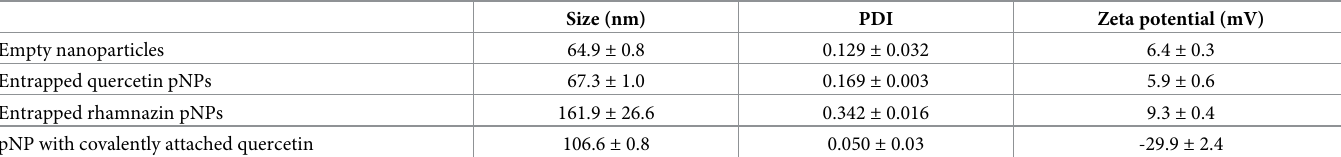
Table 1. Physical Characteristics of the nanodelivery